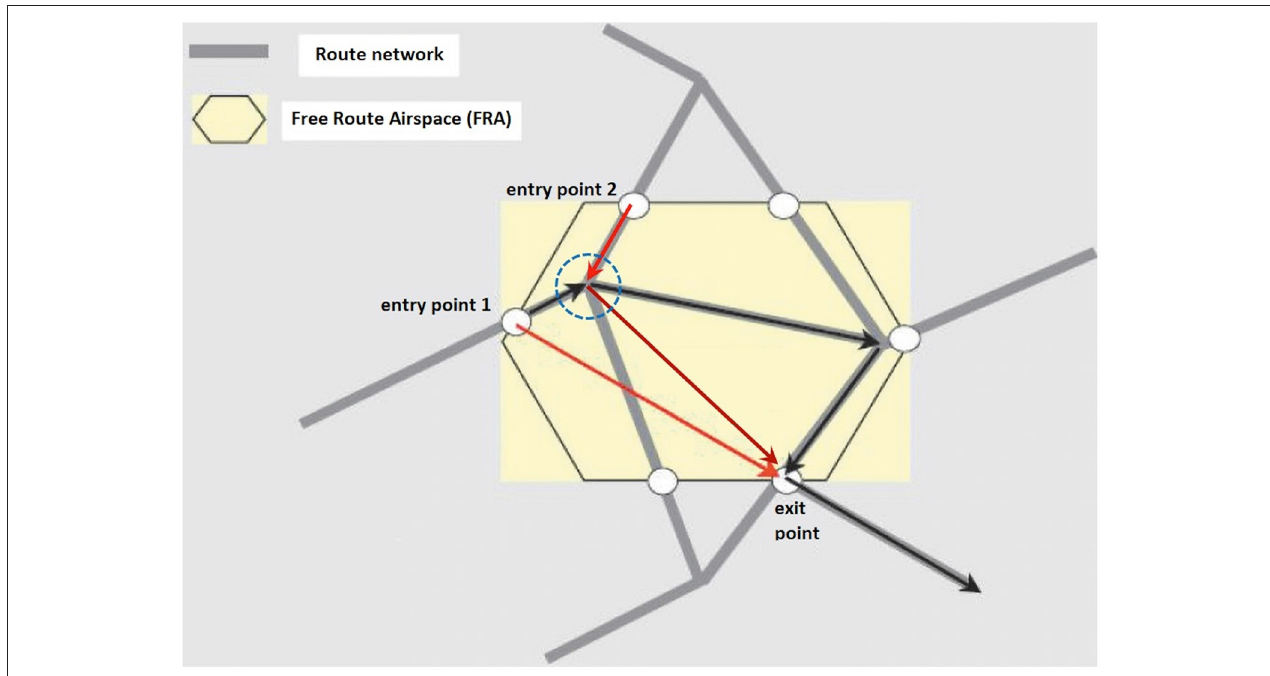
FIGURE 1 | Schematic diagram of a hypothetical free route airspace (FRA). Fixed air routes that are pre-established according to an initial flight plan are delineated in gray. Free air routes, marking out shorter and more direct paths to an exit point, are delineated in red. In this fictional scenario, the spatial orientation ability of an air traffic controller (ATCO) matters at a “crossing point” of two air routes (circled in dashed blue lines) at which aircraft heading changes are set to occur. For an aircraft traveling on a fixed route (black arrows from entry point 1 to exit point) and another traveling on a free route (red arrows from entry point 2 to exit point), an ATCO must be extra vigilant of their orientation changes at the prospective crossing point on the radar screen so as to prevent the occurrence of any conflict between the aircraft. This is especially so when the two aircraft fly at similar airspeeds and at flight levels that differ by 1,000 feet or less (Adapted with permission from Figure 1 of Antulov-Fantulin et al.,